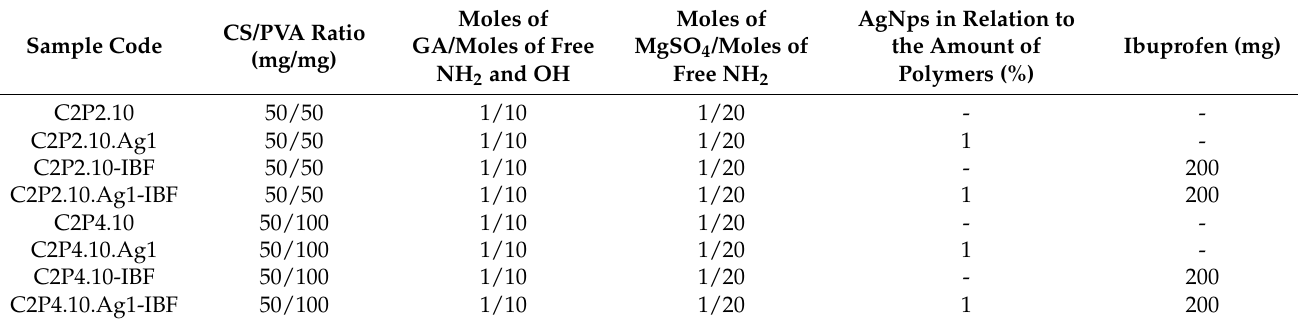
Table 2. Experimental plan used for films